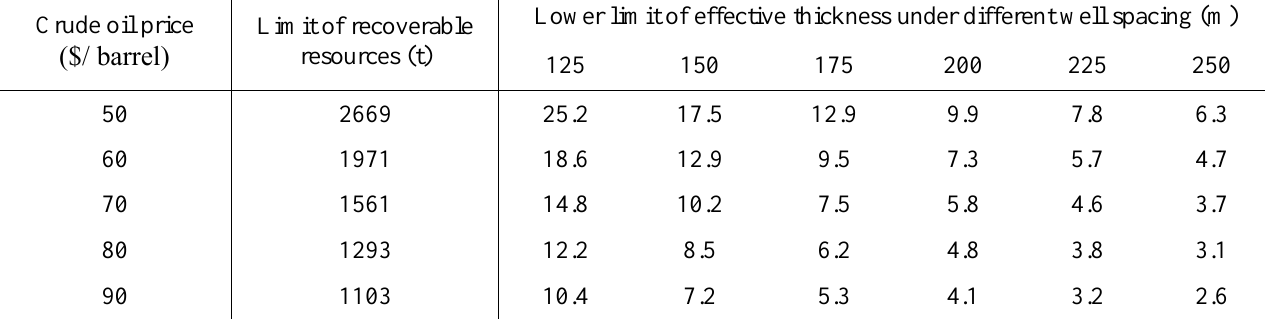
Table 2—The limit of effective thickness under different well